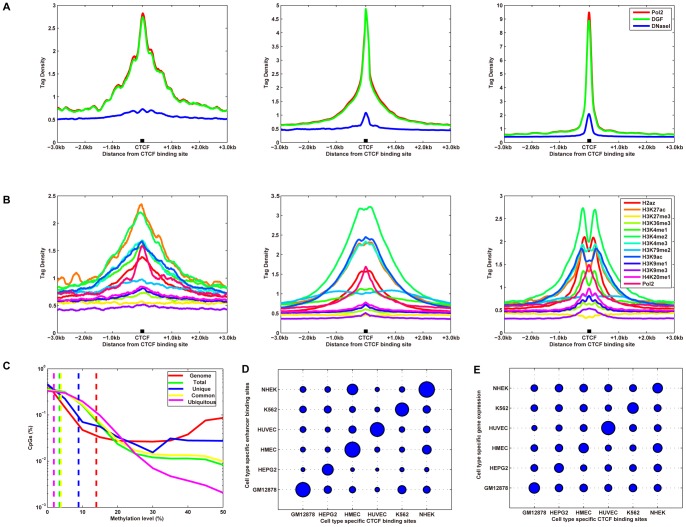
Chromatin features of CTCF-binding sites.(A) Open chromatin proximal to CTCF-binding sites in K562 cells. DNaseI HS, DNaseI DGF, and FAIRE profiles of cell type-specific (left), common (middle), and ubiquitous (right) CTCF-binding sites. The tag density for open chromatin is shown across the CTCF-binding sites and extending 3 kb upstream and downstream of the CTCF-binding sites. (B) Histone modifications proximal to the CTCF-binding sites in K562 cells. Histone modification profiles of cell type-specific (left), common (middle), and ubiquitous (right) CTCF-binding sites. The tag density for modifications is shown across the CTCF-binding sites and extending 3 kb upstream and downstream of the CTCF-binding sites. (C) The smoothed distributions of CpG methylation levels within different types of CTCF-binding sites in K562 cells (for CpGs with ≥10-fold coverage). The distributions of methylation levels (%) across all CpGs identified in all, unique, common, and ubiquitous CTCF-binding sites are illustrated as a smooth approximation of probability density, which was estimated based on a normal kernel function. The x-axis represents the density of the methylation levels. The median methylation levels of different types of CTCF sites are illustrated as vertical, dashed lines. (D, E) CTCF-binding sites colocalize with strong enhancers (D) and gene expression (E) in a cell type-specific manner. (D) Cell-type specific CTCF-binding sites (x-axis) are mapped relative to cell-specific enhancer binding regions (y-axis) in six different cell types. (E) Cell type-specific CTCF-binding sites (x-axis) are mapped relative to transcription start sites of genes with cell type-specific expression (y-axis). Bubble size represents the level of enrichment.